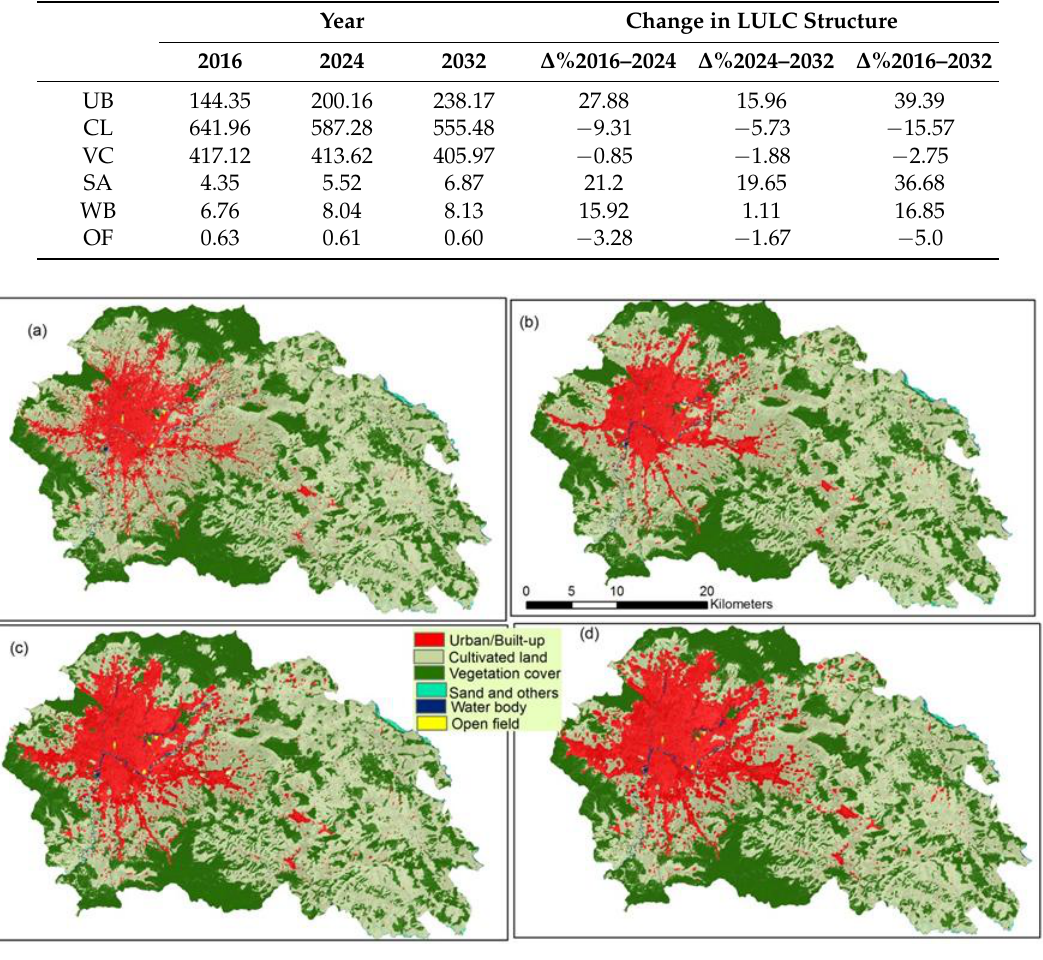
Figure 8. LULC maps: ( a ) actual map, 2016; ( b ) simulated map, 2016; ( c ) simulated map, 2024; and ( d ) simulated map, 2032. Table 7. Distribution of LULC categories (in km 2 ) and percentage of changes for 2016–2032.